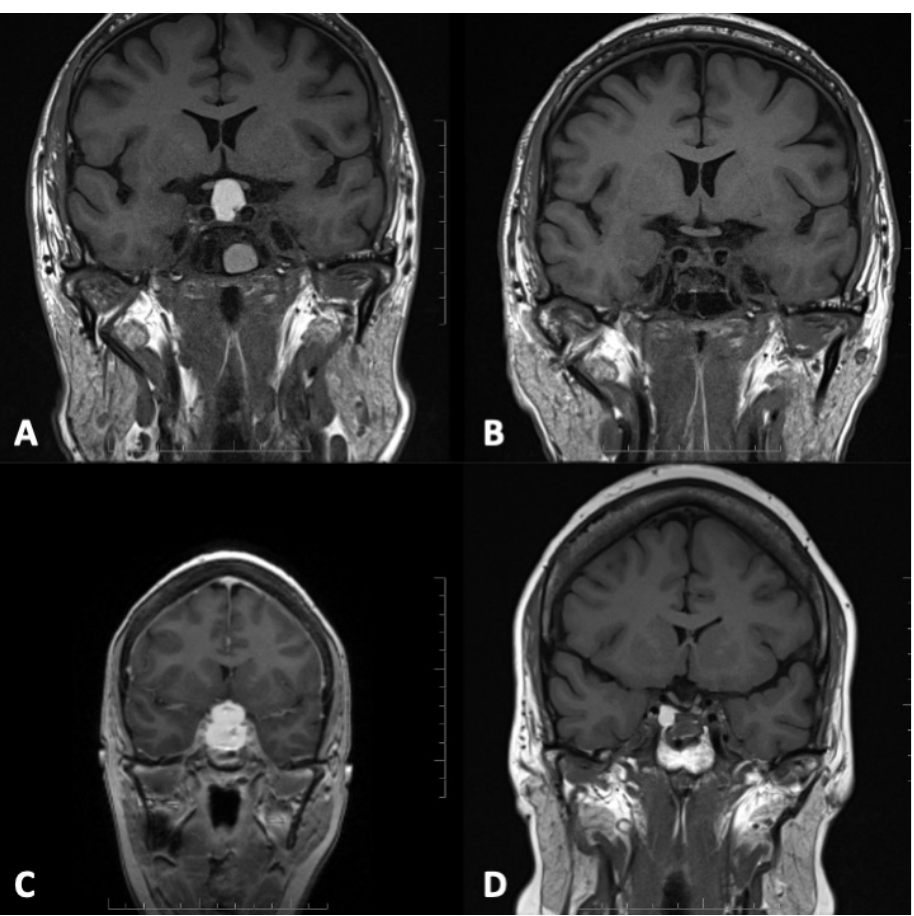
Figure 1. Preoperative ( A ) and postoperative ( B ) T1-weighted MRI of an illustrative case of a patient with suprasellar extension and chiasmal compression of a RCC that underwent CWR is shown in the upper row of the figure. In the lower part, preoperative ( C ) and postoperative ( D ) T1-weighted MRI also depict an illustrative patient with a Rathke’s cleft cyst in whom SF was performed. were noted in four patients (10%). These included a CSF leak in two cases (5%) and one of